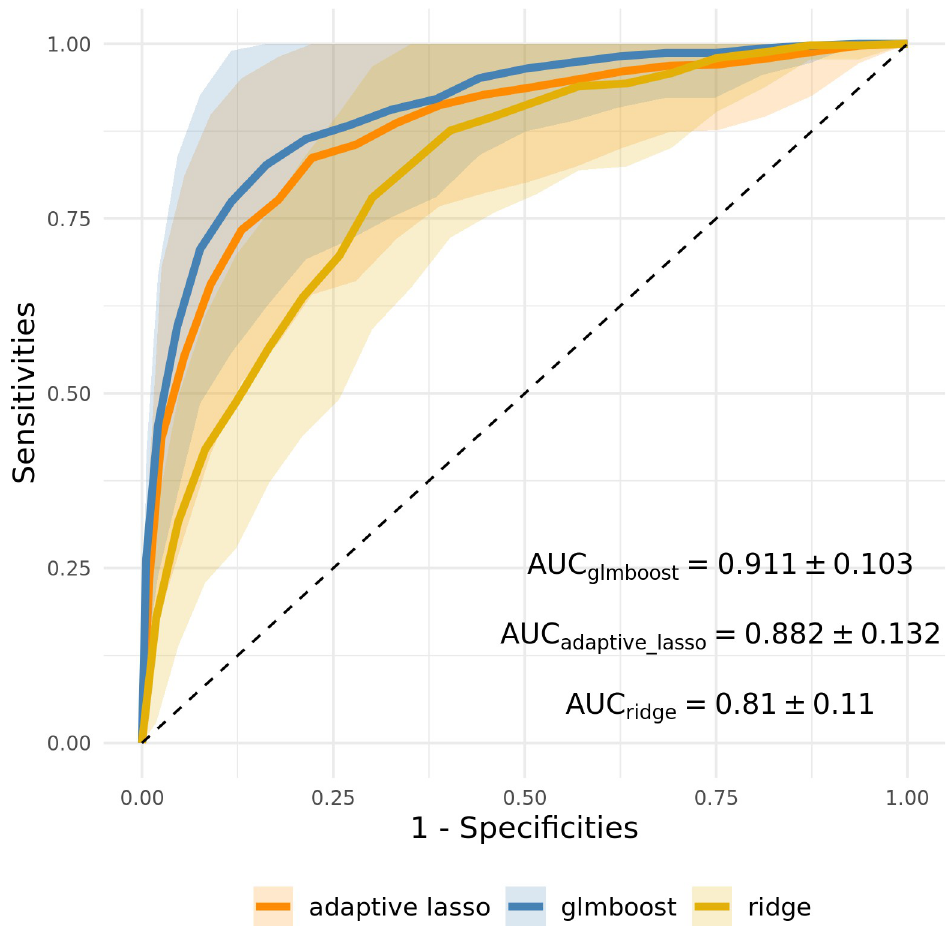
Fig 1. Averaged ROC curves of test results of the first simulation experiment. The shaded areas represent the one standard deviation interval of the corresponding methods, estimated via 100 realizations.